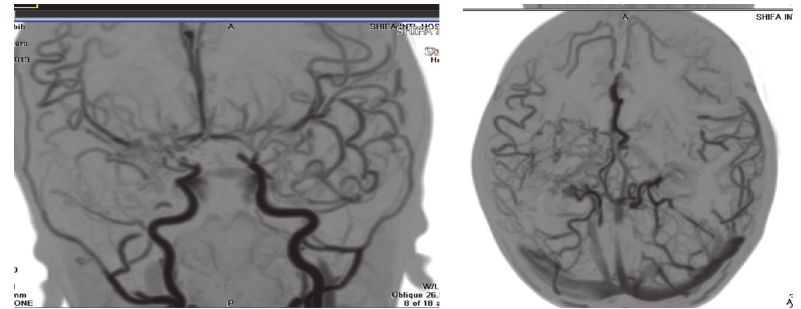
Figure 1: Preoperative CTA head showing stenosis of supraclinoid parts of bilateral ICA.